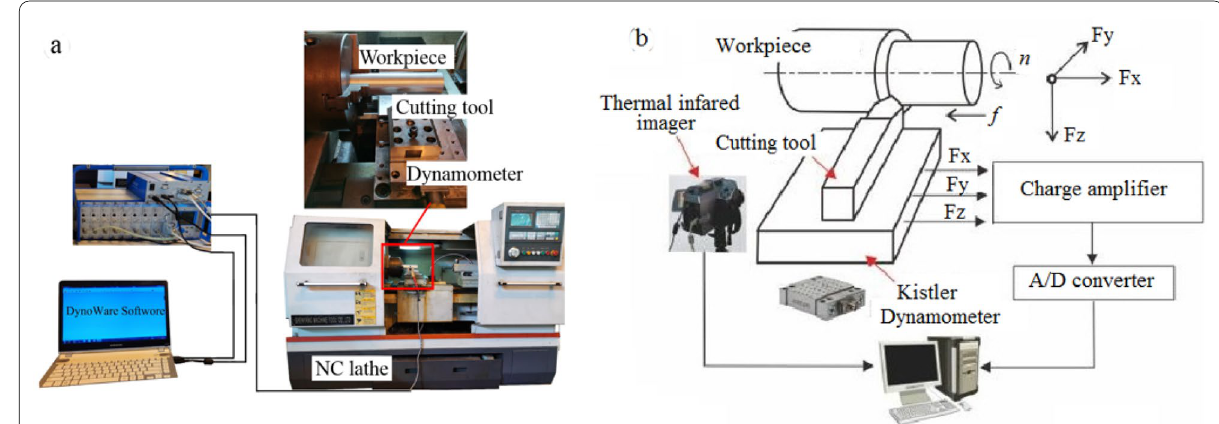
Figure 1 Experimental system. a Experimental setup. b Schematic diagram [8]